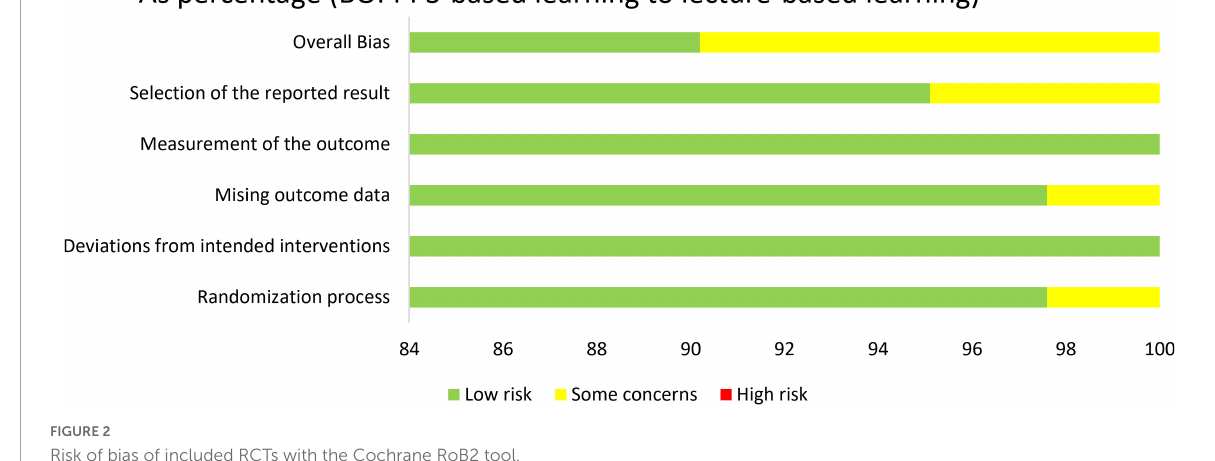
FIGURE2 Risk of bias of included RCTs with the Cochrane RoB2 tool.